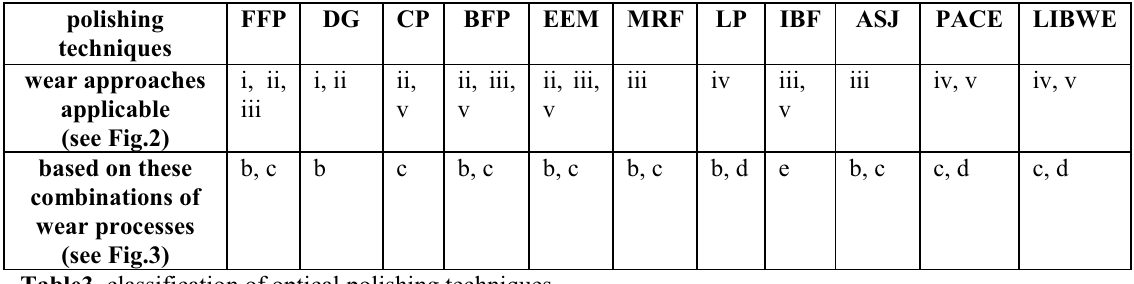
Table3. classification of optical polishing